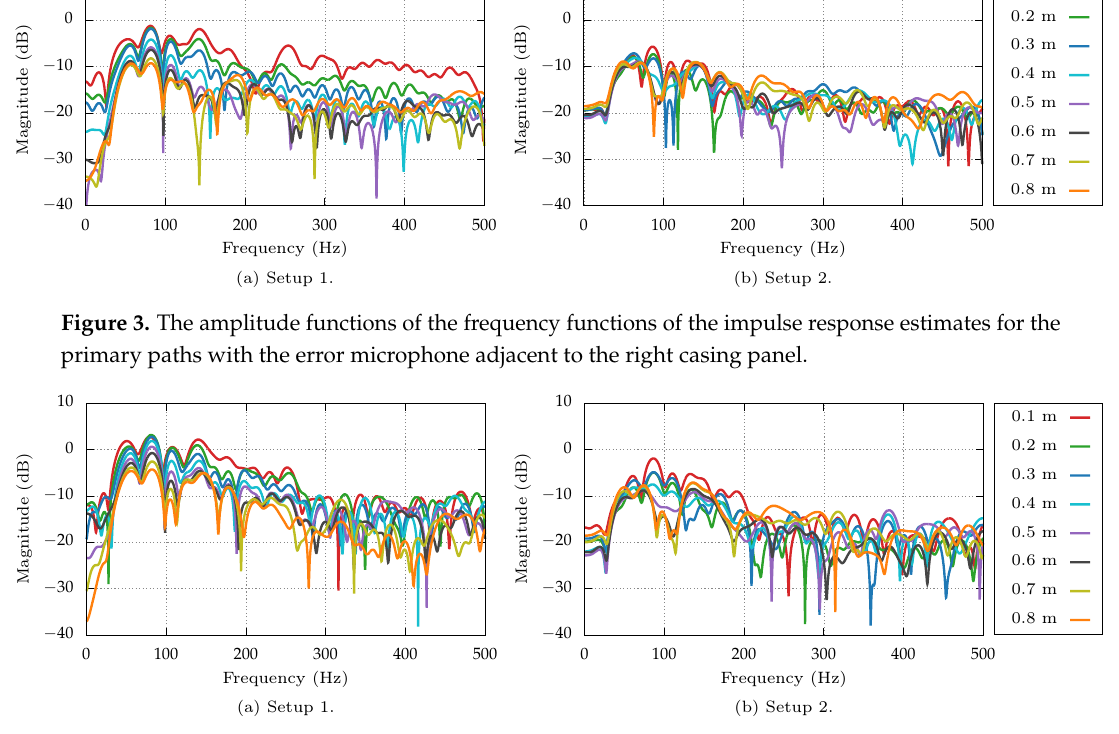
Figure 4. The amplitude functions of the frequency functions of the impulse response estimates for the primary paths with the error microphone adjacent to the back casing panel.